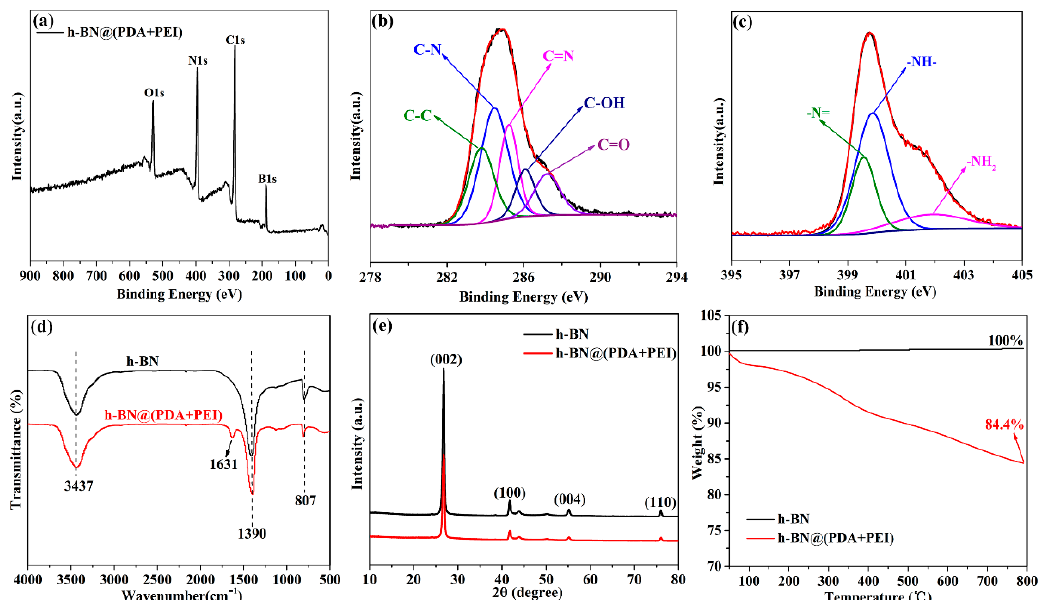
Figure 2. The characterization of h-BN samples: ( a ) XPS wide scan; ( b ) C 1s spectra; ( c ) N 1s spectra; ( d ) FT-IR spectra; ( e ) XRD patterns; ( f ) TGA curves.